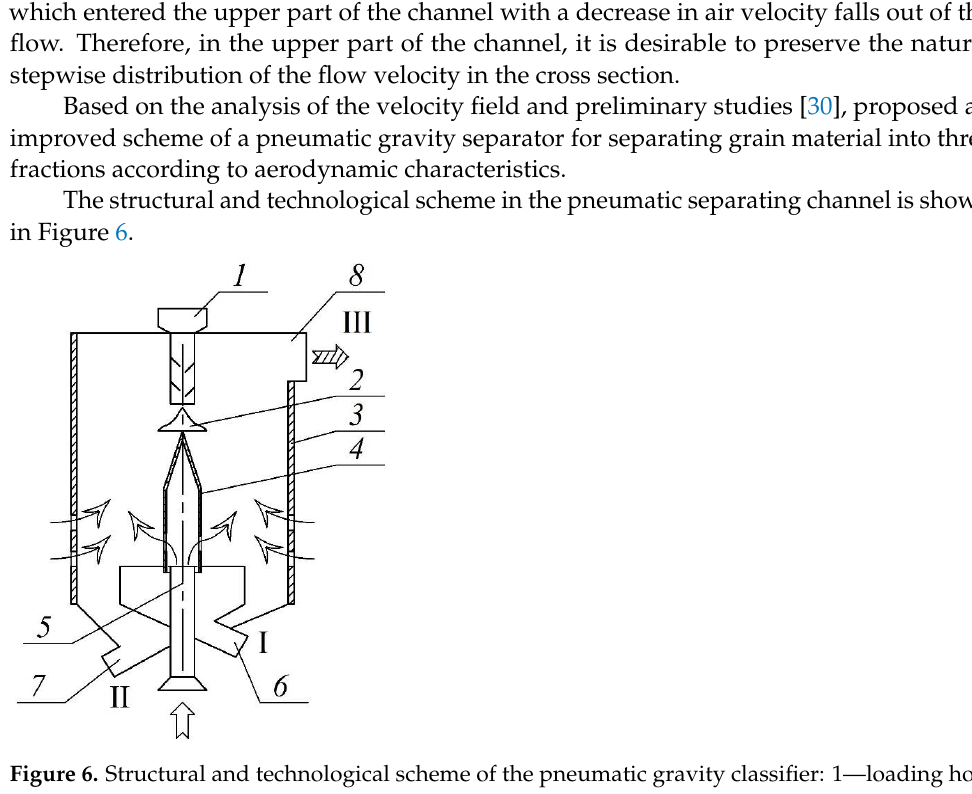
(29) It has been established in the work that the change in the air velocity in a vertical channel in the direction of its movement according to the laws (27)–(29) makes it possible to significantly change the trajectory of grains with different values of (cid:1863) (cid:3023) and increase the deviation of the trajectories ∆ x with a uniform distribution of air velocity. So, the data of the trajectory of the movement of grains are visualized in Figure 7. Thus, changing the sign of the direction of the air velocity gradient in the cross section of the vertical channel allows you to increase the trajectory splitting factor (Δx) by 15–25% and the efficiency factor by 17–21%.